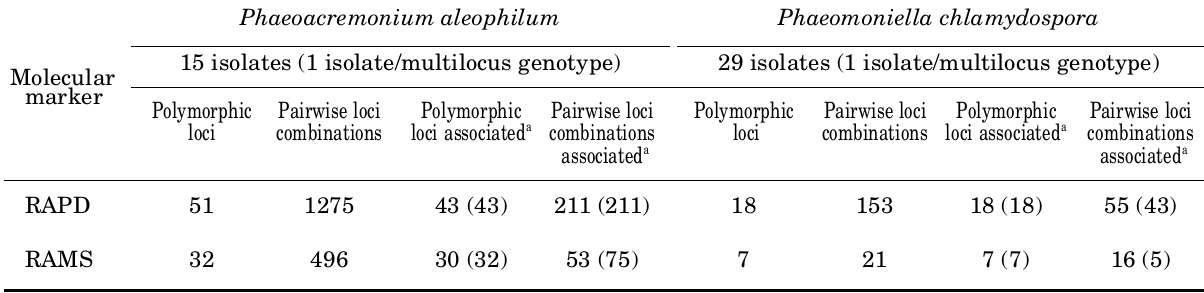
Table 4. Total number of polymorphic loci and of all pairwise loci combinations, and number of polymorphic loci and of pairwise loci combinations with significant non-random association, from RAPD and RAMS data on Phaeoacre- monium aleophilum and Phaeomoniella chlamydospora . For each species the parameters evaluated included all the individuals of the sample or one isolate for each multilocus genotype (between